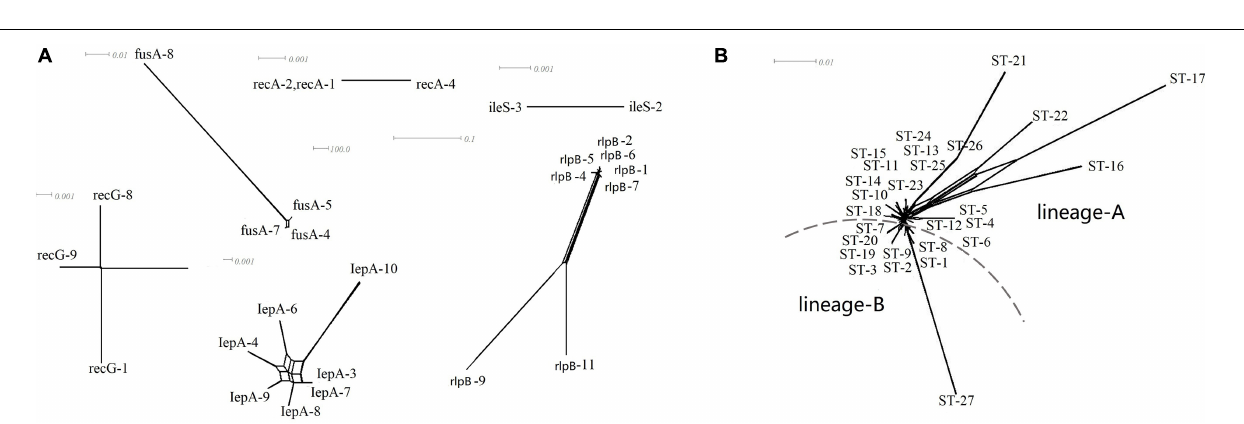
FIGURE 4 | (A) Minimum-spanning tree analysis of 106 L . paracasei strains based on rep-PCR and multilocus sequence typing (MLST) date according to the individual. Different colors in the figure represent different sample sources. Each circle indicates a sequence type (ST); the size of the circle is proportional to the number of individuals sharing the same ST. (B) Minimum-spanning tree analysis of 64 representative L . paracasei strains based on MLST date according to region. Each circle indicates a ST; the size of the circle is proportional to the number of strains, and the type of line between isolates indicates the strength of the genetic relationship between these isolates (black line, strong relationship; gray line, intermediate relationship; dotted line, weak relationship), The different colors represent the strains isolated from different ethnic groups.